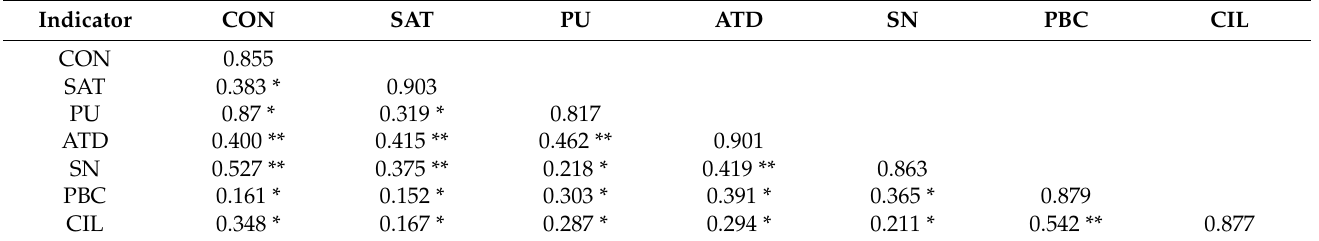
Table 4. Discriminant